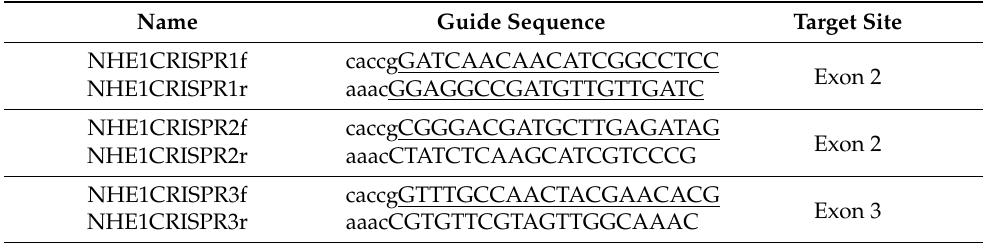
Table 2. Synthetic oligonucleotides used to knock out the NHE1 protein. Guide sequences are underlined, and added bps used for restriction enzyme cloning are shown in lower